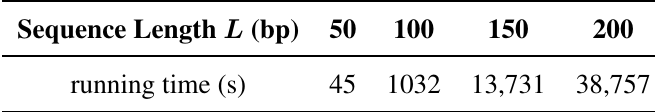
Table 1. Average running times of the BnC algorithm for L = 50 bp, 100 bp, 150 bp, and 200 bp. For L = 200 bp, we compute the average over all instances except for the H. sapiens splice donor